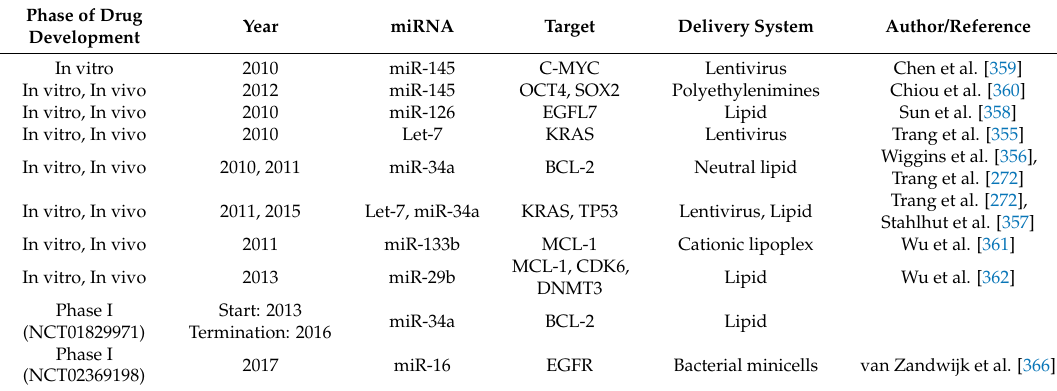
Table 5. MicroRNA-targeted therapy for lung